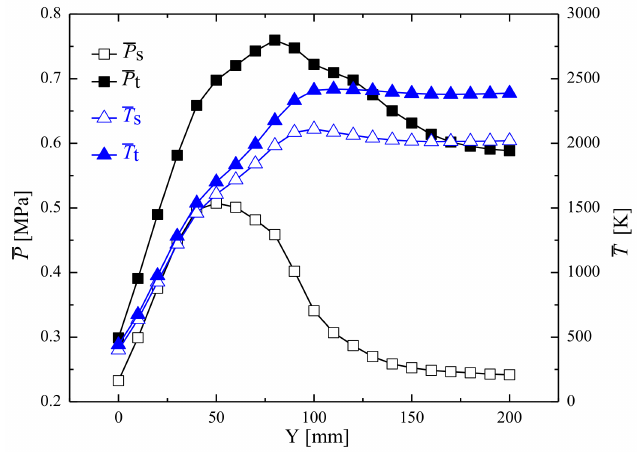
Figure 8. Pressure and temperature of CRD combustor cross-section in the axial direction.